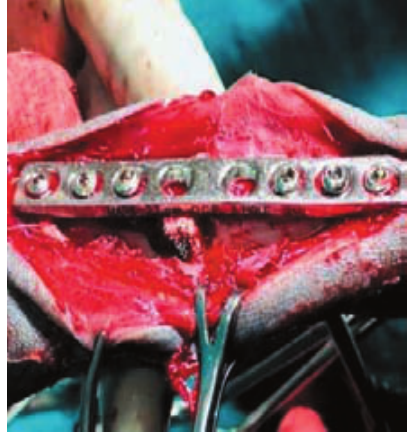
Figure 2: Biograft material filled into the fracture gap after fracture fixation with plates and screws.